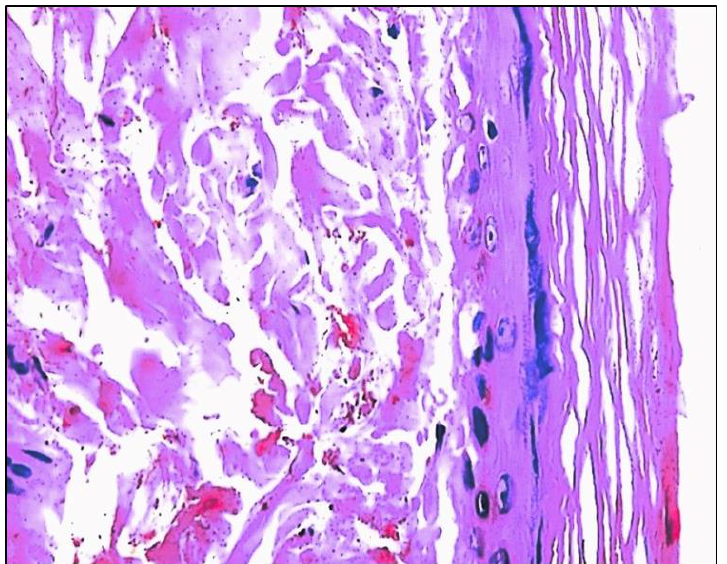
Figure 2. Photomicrograph of the histological cut (hematoxylin-eosin stain 400X). The cystic cavity lined by orthokeratinized stratified squamous epithelium and lumen partially filled by orthokeratine is observed and the fibrous connective tissue wall.